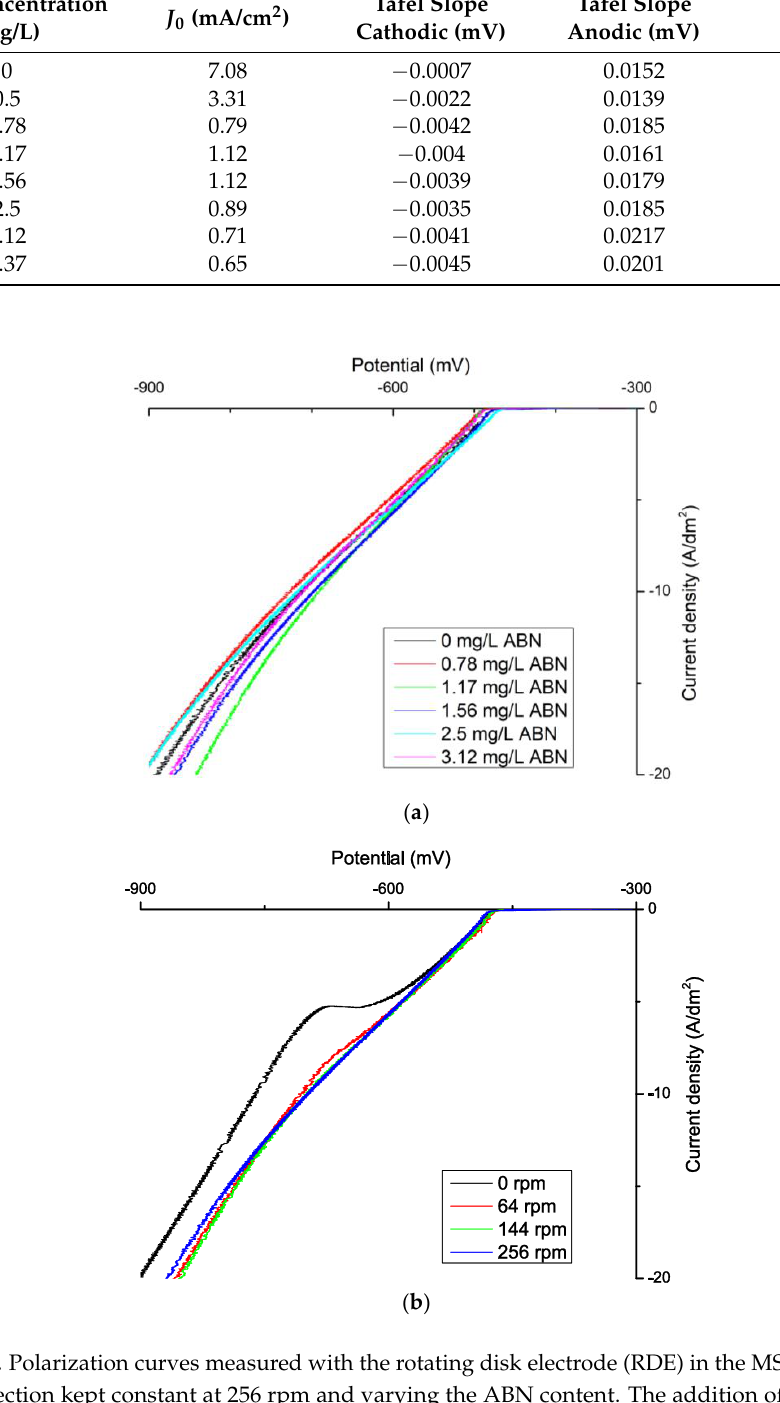
Table 2. Influence of the alkoxylated β -naphthol (ABN) concentration on the kinetics parameters in the chloride electrolyte.